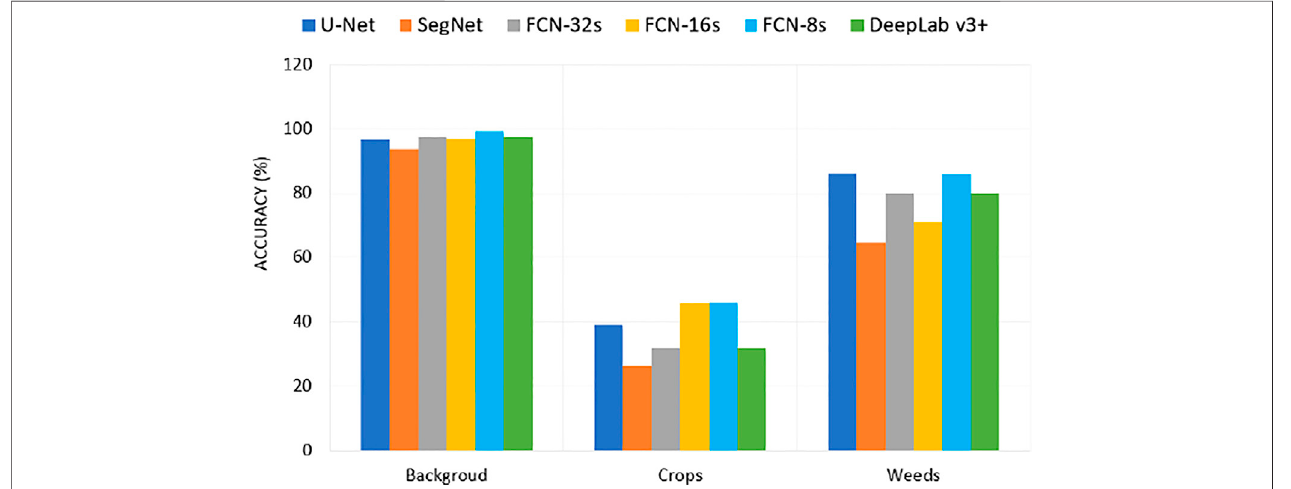
FIGURE 10 | Segmentation results for each of the individual classes for the sugarcane dataset.